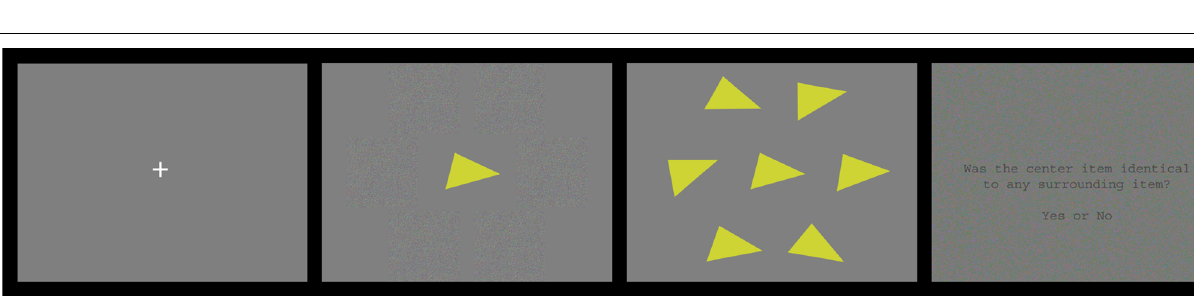
FIGURE 2 | Trial sequence for simultaneous presentation condition. From left to right: fi xation; sample presentation (2s); sample persists and search array appears (6s); response